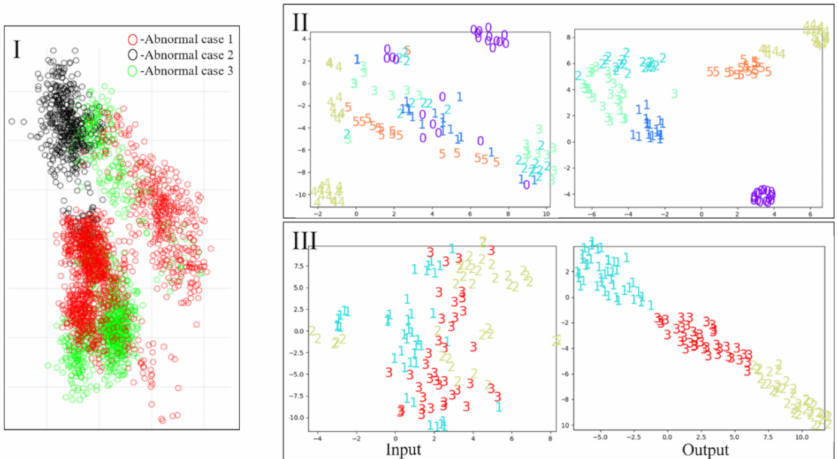
Figure 5. Visualization results of R-22 processes obtained by K-means and t-distributed stochastic neighbor embedding (t-SNE). ( I ) K-means clustering results. ( II ) and ( III ) t-SNE visualization results